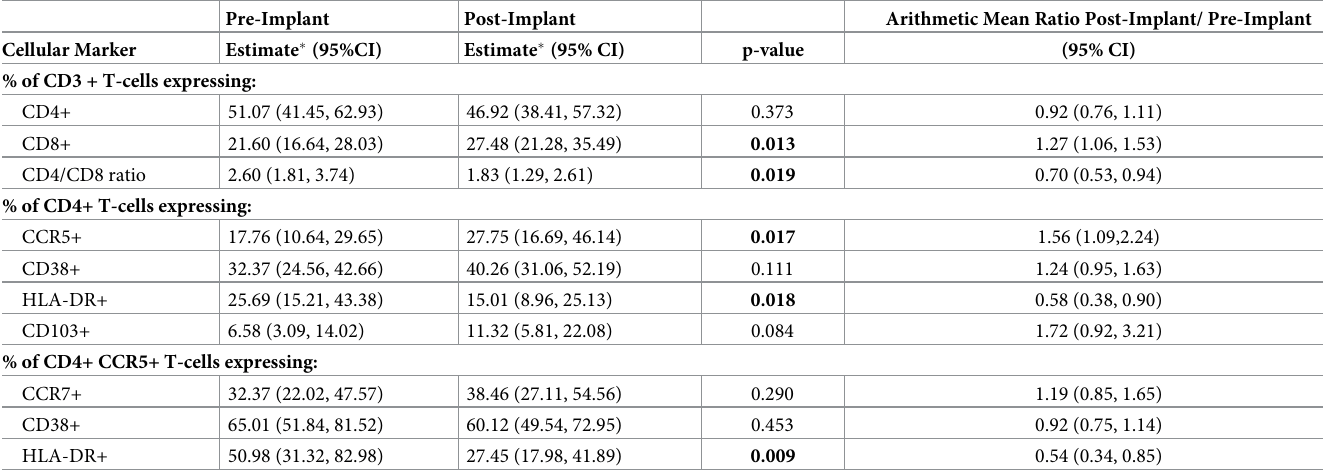
Table 3. Estimated cellular marker levels in the CVL for implant users, adjusting for repeated measures and covariates. Pre-Implant Post-Implant Arithmetic Mean Ratio Post-Implant/